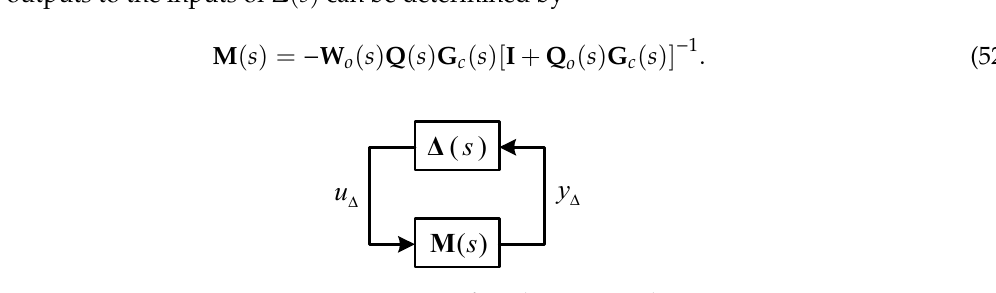
Figure 7. M -Δ structure for robustness analysis. Figure 7. M − ∆ structure for robustness